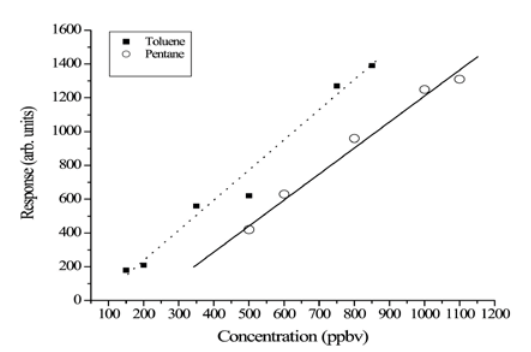
Figure 2. Calibration curves for toluene and pentane using CH as the CI